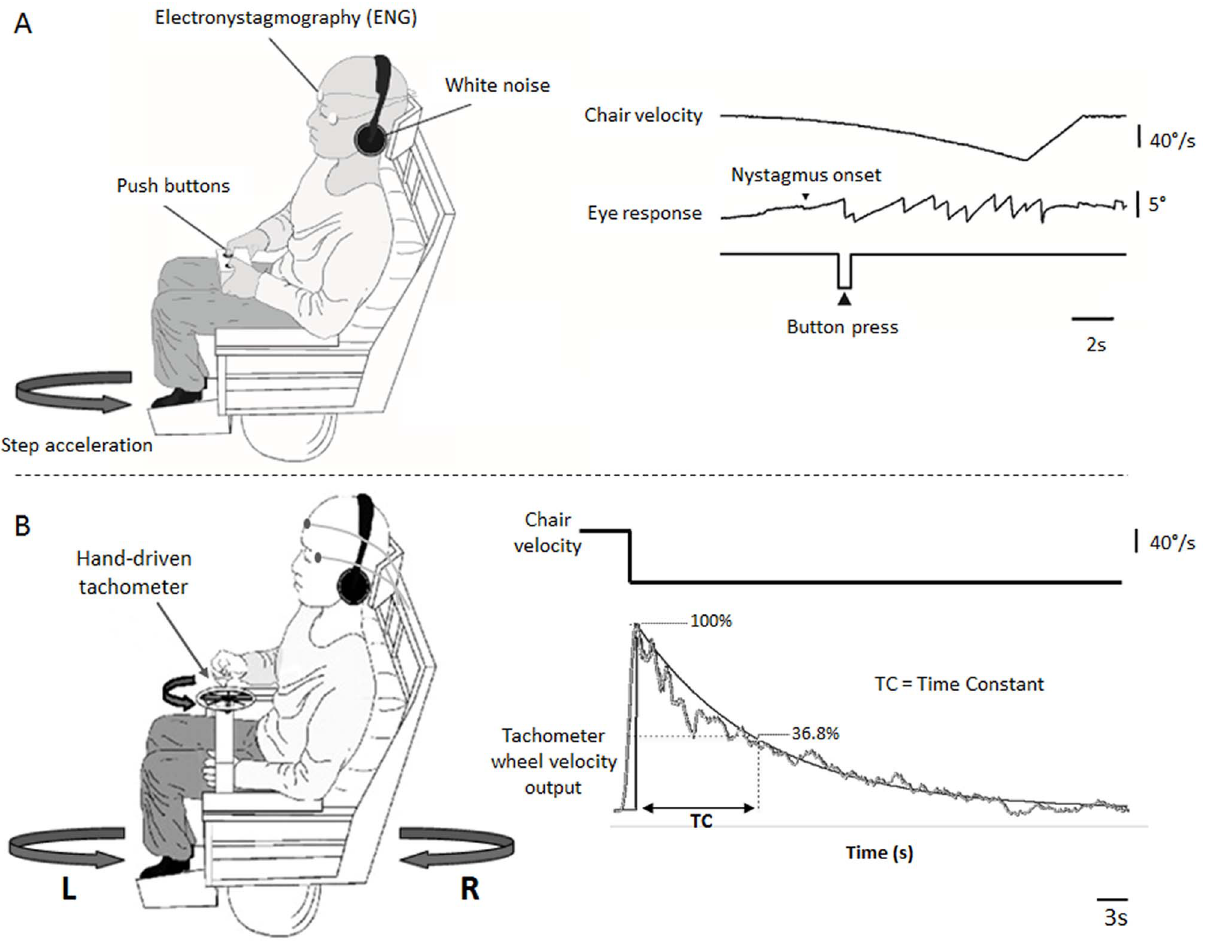
Figure 1. Schematic diagram showing a subject sitting on the rotating chair for simultaneous psychophysical and eye movement (ENG) assessment in the dark. A: Threshold vestibular task. The subject carries a hand-held device with two buttons (left and right) whilst exposed to step acceleration rotations with an initial acceleration of 0.5 u /s 2 , increasing by 0.5 u /s 2 every 3 s. The subject presses the appropriate button to indicate perceived direction (leftward vs. rightward) as soon as they were sure they were moving in a particular direction. Vestibulo-perceptual (VP) thresholds were measured by the time taken from chair acceleration onset to button press (button press) and converted to u /s when appropriate. The vestibulo-ocular (VO) threshold was measured as the point at which the slow-phase eye velocity curve left the baseline and did not return (nystagmus onset). B: Supra-threshold vestibular task. Subjects in the motorised rotating chair were exposed to a velocity step of 90 u /s for 60 s, either leftwards or rightwards. They were instructed to turn the wheel at maximal speed on starting/stopping rotation (the point of maximal subjective and ocular angular velocity) and to slow the tachometer speed in proportion to their own perceived slowing of rotational velocity [10]. A representative raw trace and fitted exponential curve from the tachometer wheel in a normal subject is shown on the right. This allows for accurate measurement of the time constant (TC) of decay of the vestibular perceptual response. Vestibulo-ocular responses (not shown) were obtained using electronystagmography (ENG=EOG), and follow a similar exponential decay to the perceptual